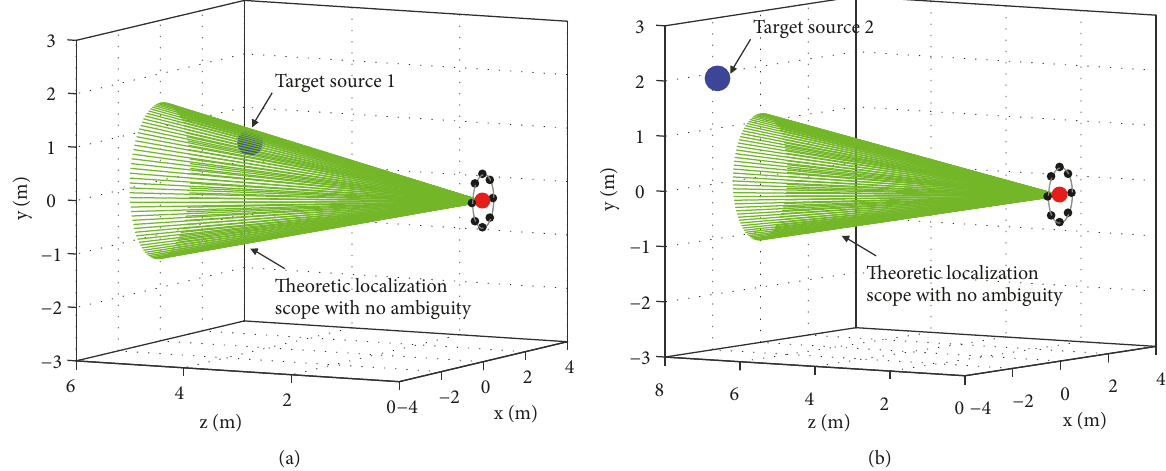
Figure 5: Source’s 3D location. (a) Source 1 ( 𝑓 = 900 MHz). (b) Source 2 ( 𝑓 = 1.5 GHz).